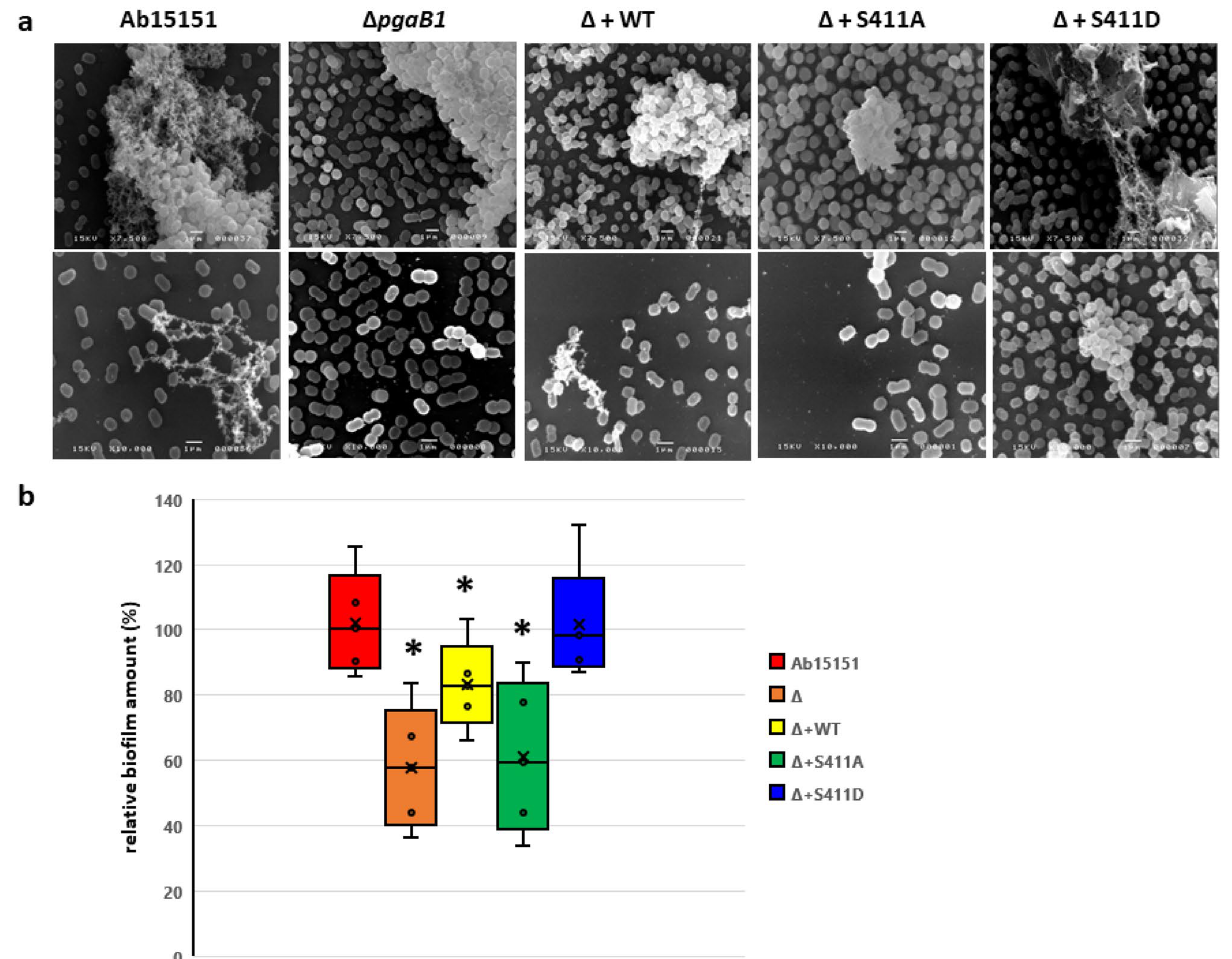
Figure 3. Observation and quantification of biofilm production in A. baumannii ATCC15151 and the AbpgaB1 -mediated mutant strains. ( a ) Observation of biofilm formation in Ab15151 and its derivatives via SEM. The upper panel showed the view with 7,500 × magnification and the lower panel showed with 10,000 × magnification. The bar indicated a scale of 1 µm. ( b ) Biofilm was quantified by crystal violet staining and determined the absorbance at 595 nm. The OD 595 values of Ab15151 were defined as 100% to calculate the relative biofilm amounts from its derivative mutant strains. Each data point was averaged from at least 6 repeats. *Indicated a significant difference from Ab15151 whose p-value of the t-test was less than